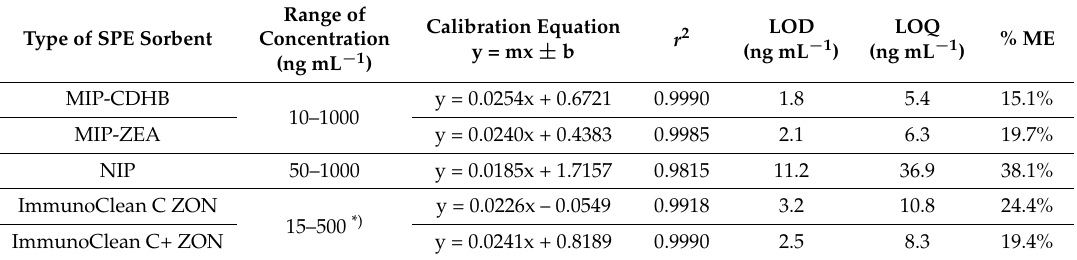
Table 5. Analytical curves (HPLC-FLD), limits of detection and quantification for ZEA in the matrix (urine).